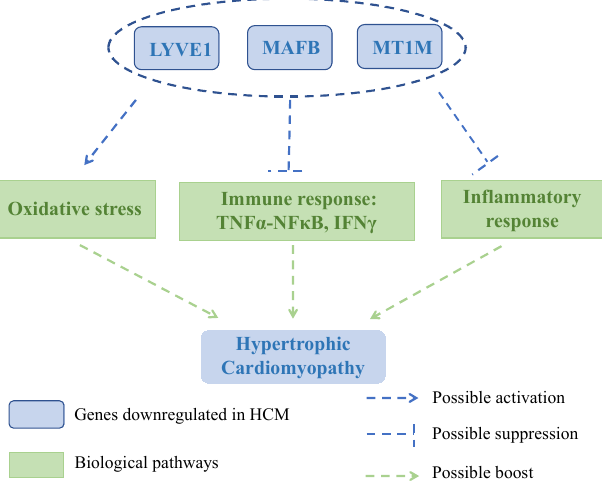
Figure 8. A scheme illustrating the potential relationships between LYVE1 , MAFB , MT1M and the possible biological pathways in HCM. The downregulations of LYVE1 , MAFB , and MT1M might induce the development and progression of HCM by activating oxidative stress while suppressing immune response and inflammatory